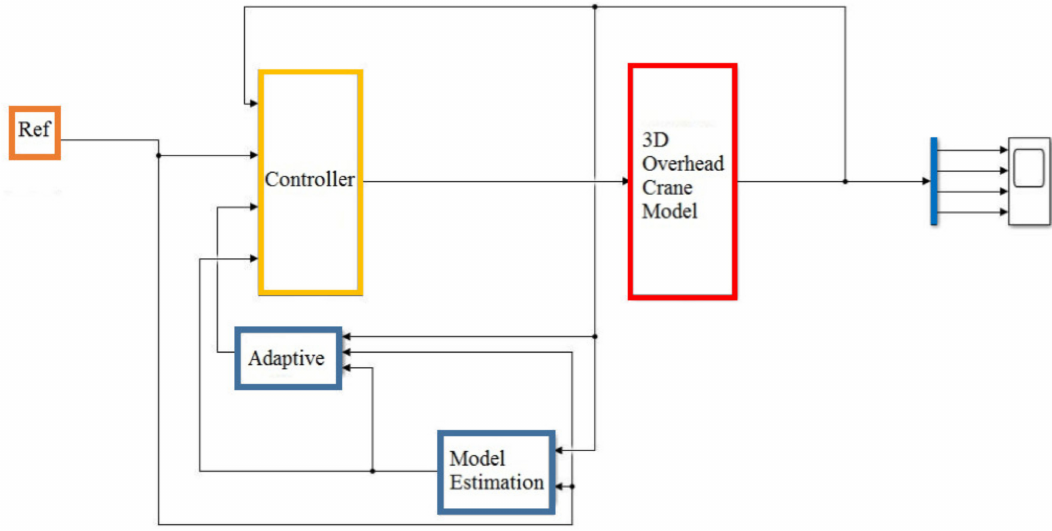
Figure 3. The simulation block diagram.